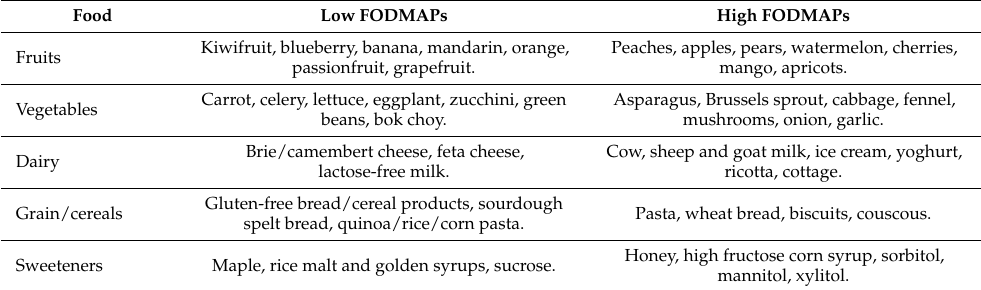
Table 2. Examples of low and high FODMAP foods, based on the standard serving